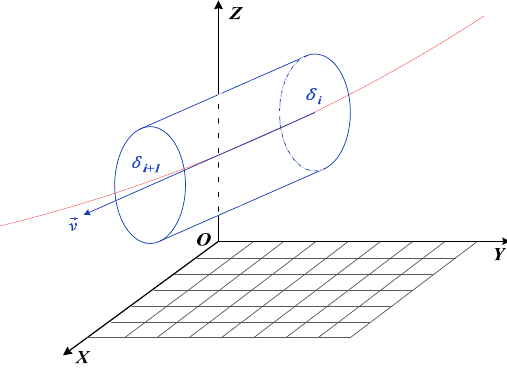
Figure 9. Diagram of Principle for Automatic Obstacle Detection.